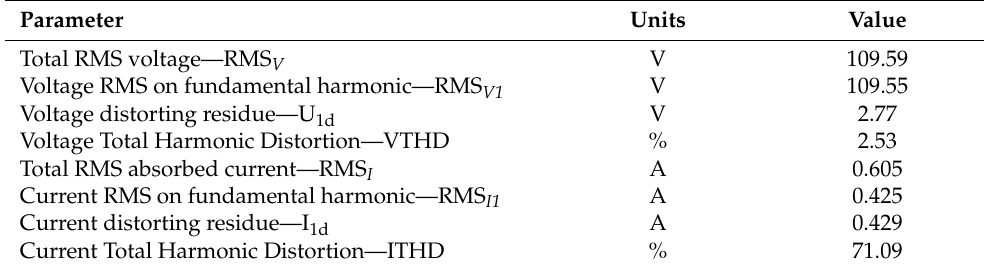
Table 1. Power quality parameters and indices for the recorded electric quantities for case 2.1. Parameter